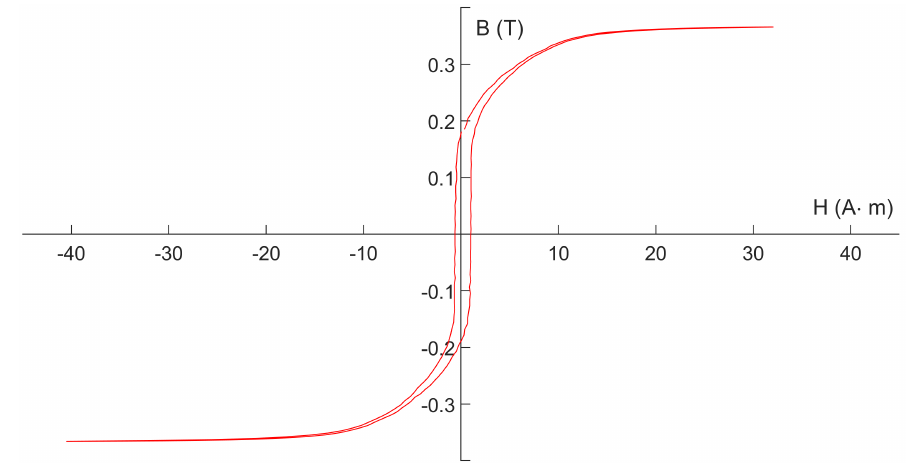
Figure 7. Hysteresis loop of the magnetic core measured at 220 ◦